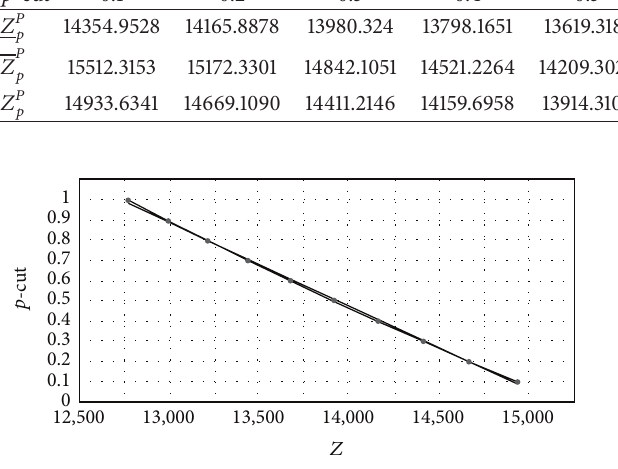
Figure 5: Optimal solution at different possibility